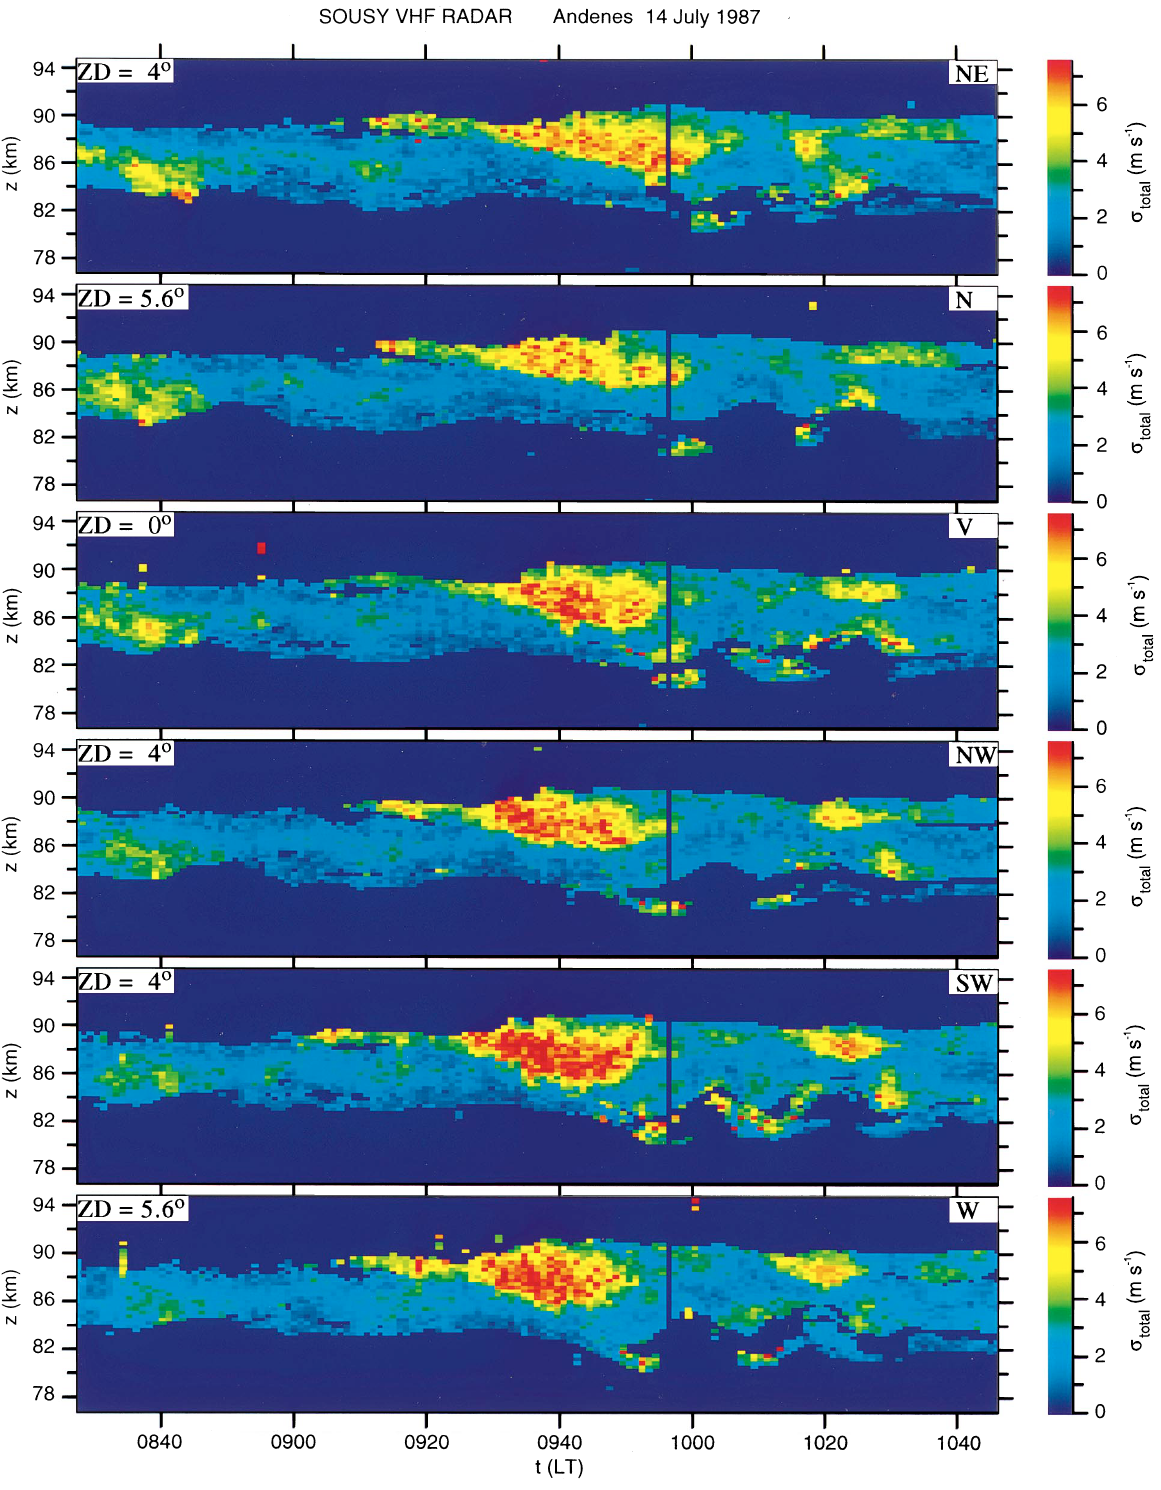
Fig. 2. Height-time plots of the total spectral width observed in six di(cid:128)erent beam